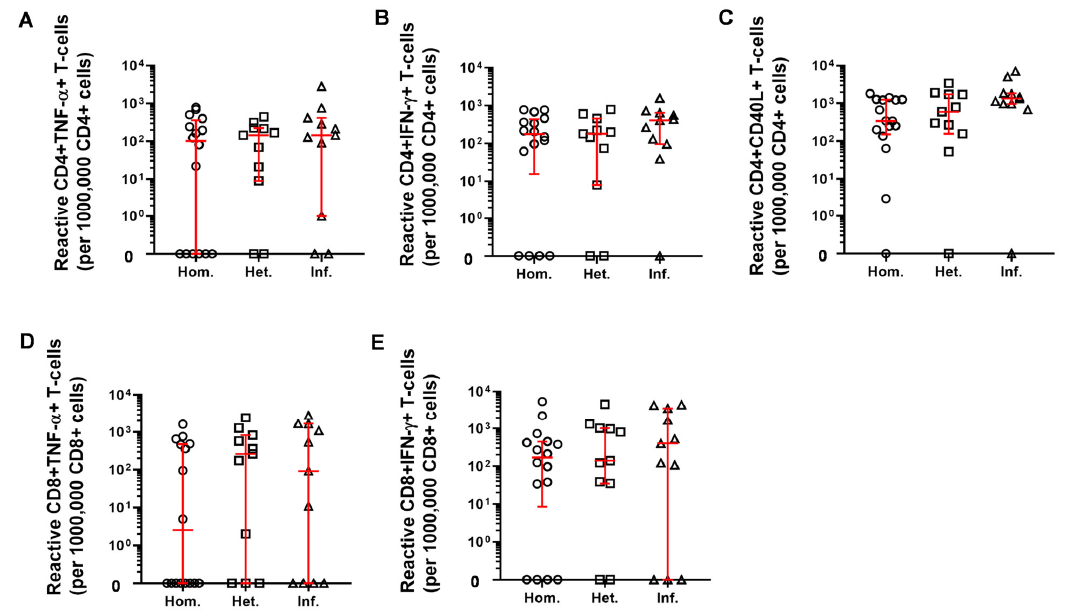
Figure 6. The quantitation of SARS-CoV-2-derived S-, M-, N-reactive peripheral T-cells ex vivo. After the withdrawal of peripheral blood, PBMCs were purified and plated for stimulation ex vivo for 16h with S-, M-, and N-peptide pools. After incubation cells were labeled with a cocktail of antibodies as described in the 4.6 Materials and Methods section. Reactive cells ( A ) CD4+/TNF- α +, ( B ) CD4+/IFN- γ +, ( C ) CD4+/CD40L+, ( D ) CD8+/TNF- α +, and ( E ) CD8+/IFN- γ + were acquired and quantified on a flow cytometer. (circles: Hom. n = 16, squares: Het. n = 11, triangles: Inf. n = 11). Horizontal lines—median, whiskers—interquartile range.